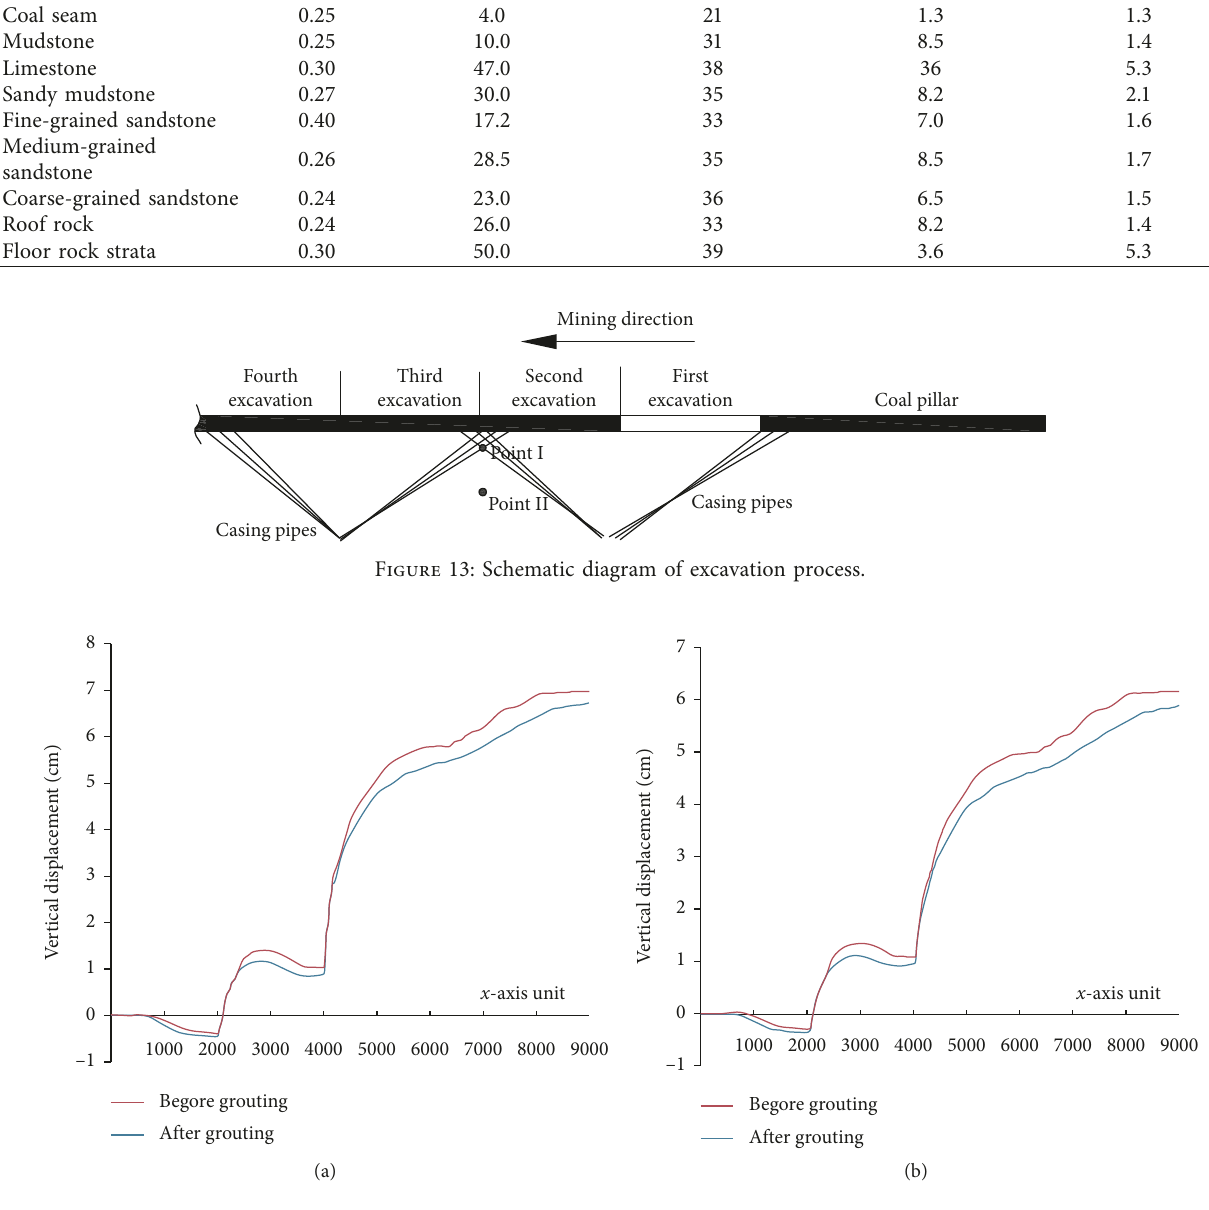
Figure 14: Displacement changes of two monitoring points with and without casing pipes (a) in the place 2 m away from coal seam floor and (b) in the place 15m away from coal seam